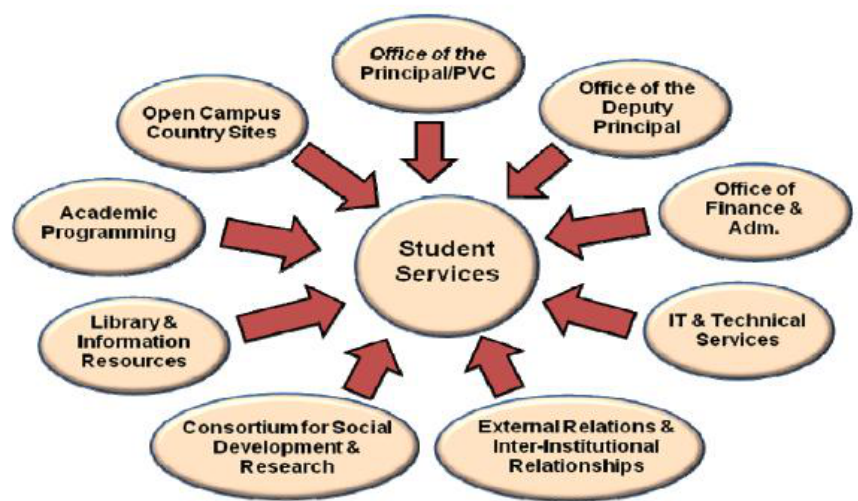
Figure 1. An organizational structure based on functional imperatives. Adapted from The University of the West Indies Open Campus Progress Report,